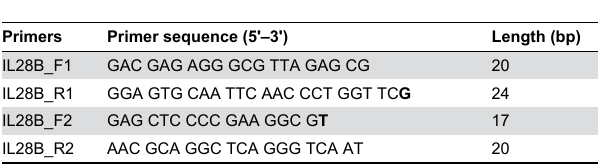
Bold: The base 3 'reverse primer (R1) is complementary to the base cytokine (C). the base 3 'primer stream (F2) is complementary to thymine base (T)